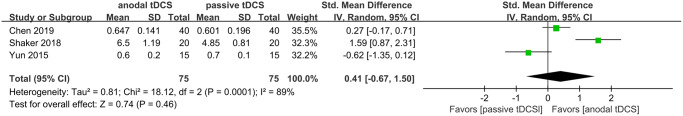
Forest plot of memory performance.